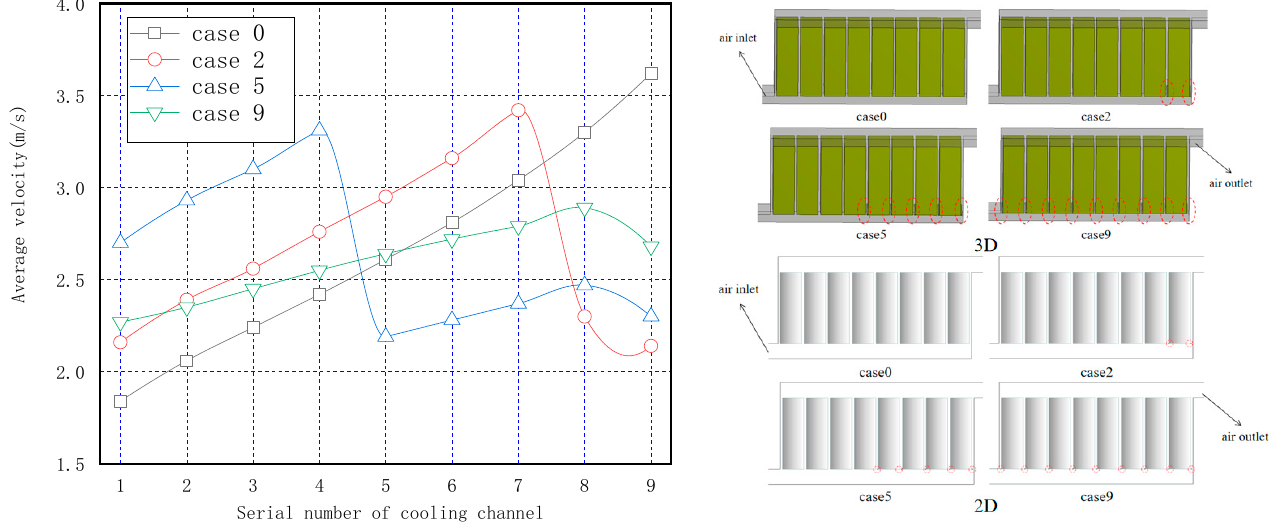
Figure 9. Airflow average velocities in nine channels for various cases.